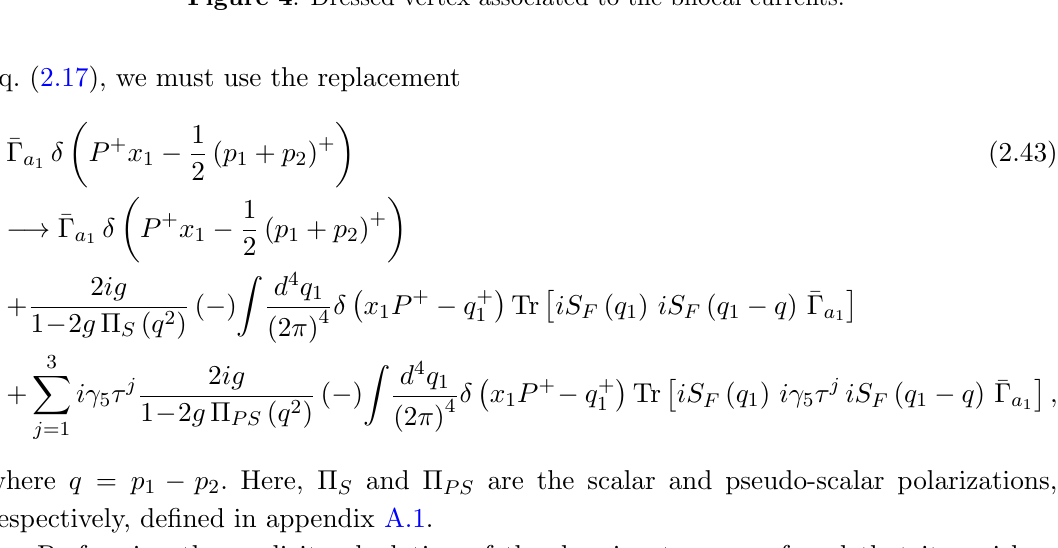
Figure 4 . Dressed vertex associated to the bilocal